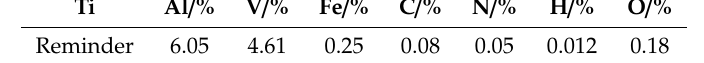
Table 1. Chemical composition of as-received Ti6Al4V alloy.